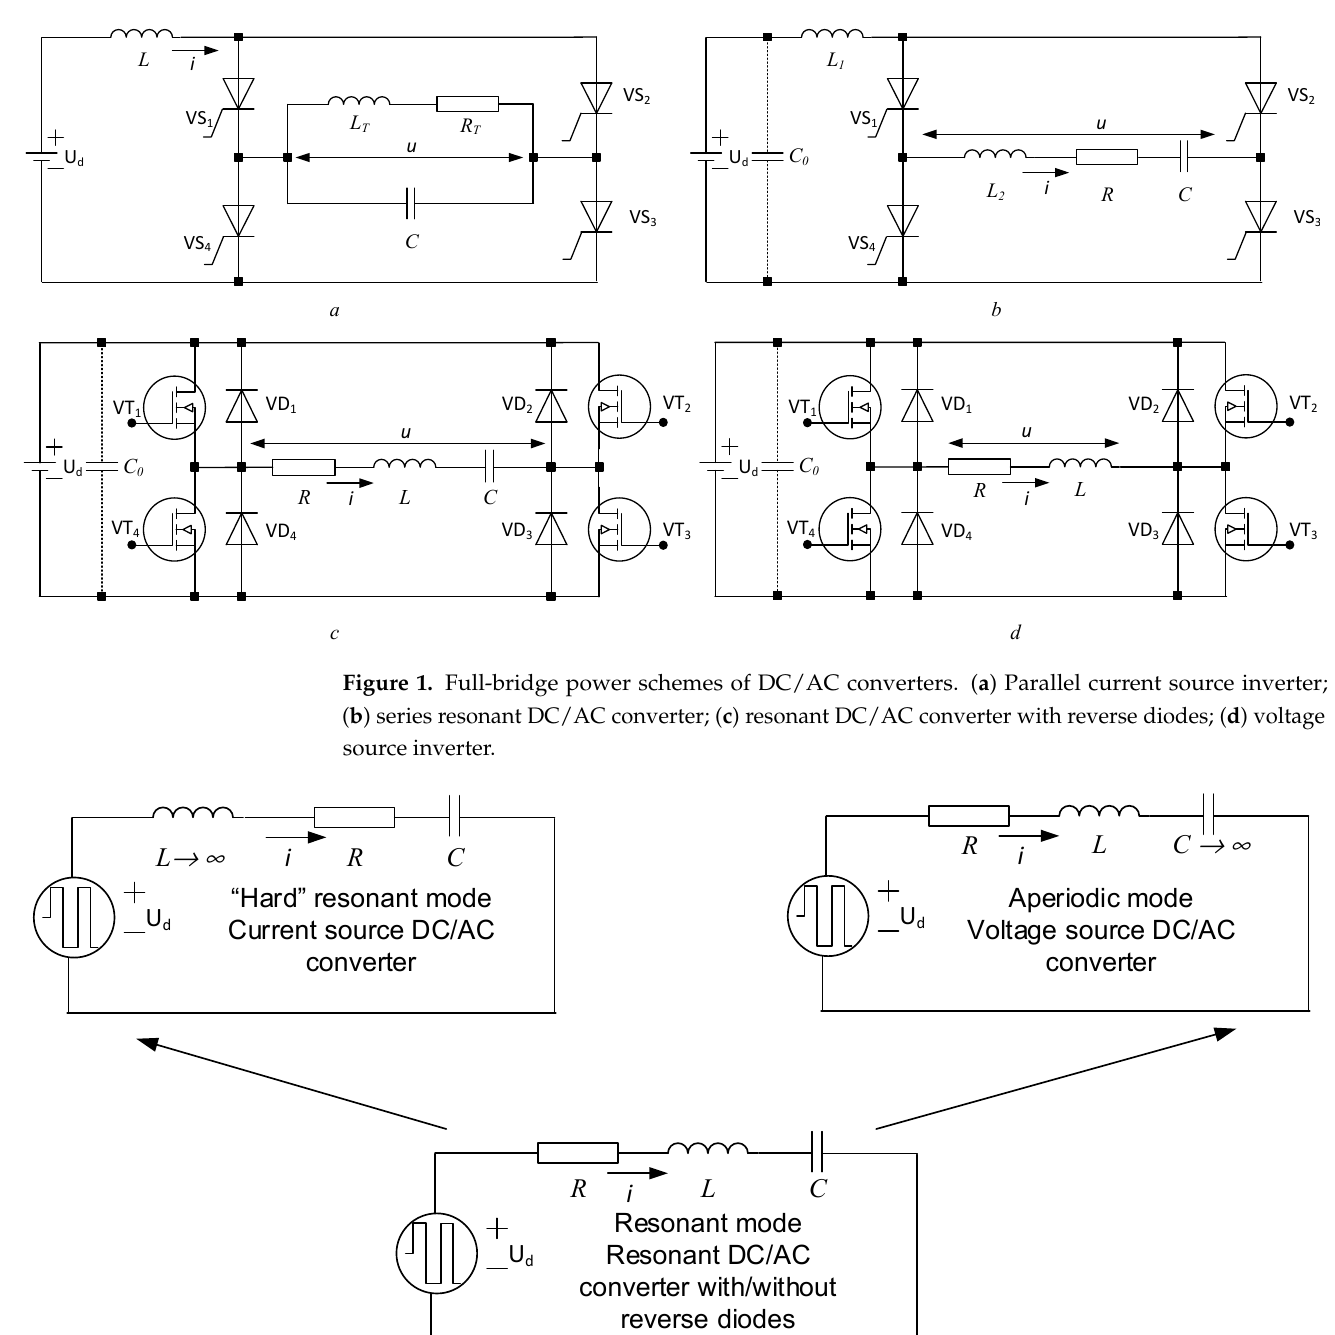
Figure 2. Generalized equivalent circuits of the three main types of DC/AC converters and the tran- sition between them. It is characteristic of all types of DC/AC that, in their analysis, a series equivalent circuit of the AC circuit is used, which achieves a community of considerations. In this sense, the unified approach is based on the use of a series RLC circuit, which describes the electromagnetic processes in the resonant DC/AC inverter with reverse diodes. The other